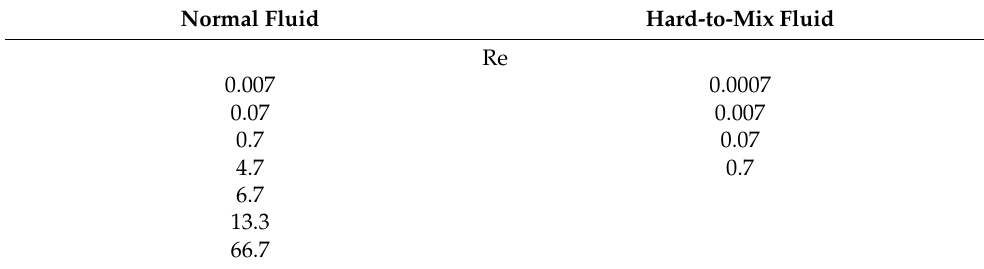
Table 1. Re numbers for the micromixer. Normal